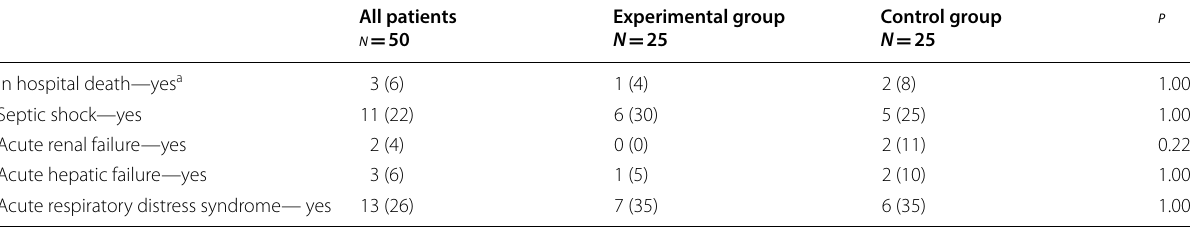
Table 4 Distribution of serious adverse events across randomization groups